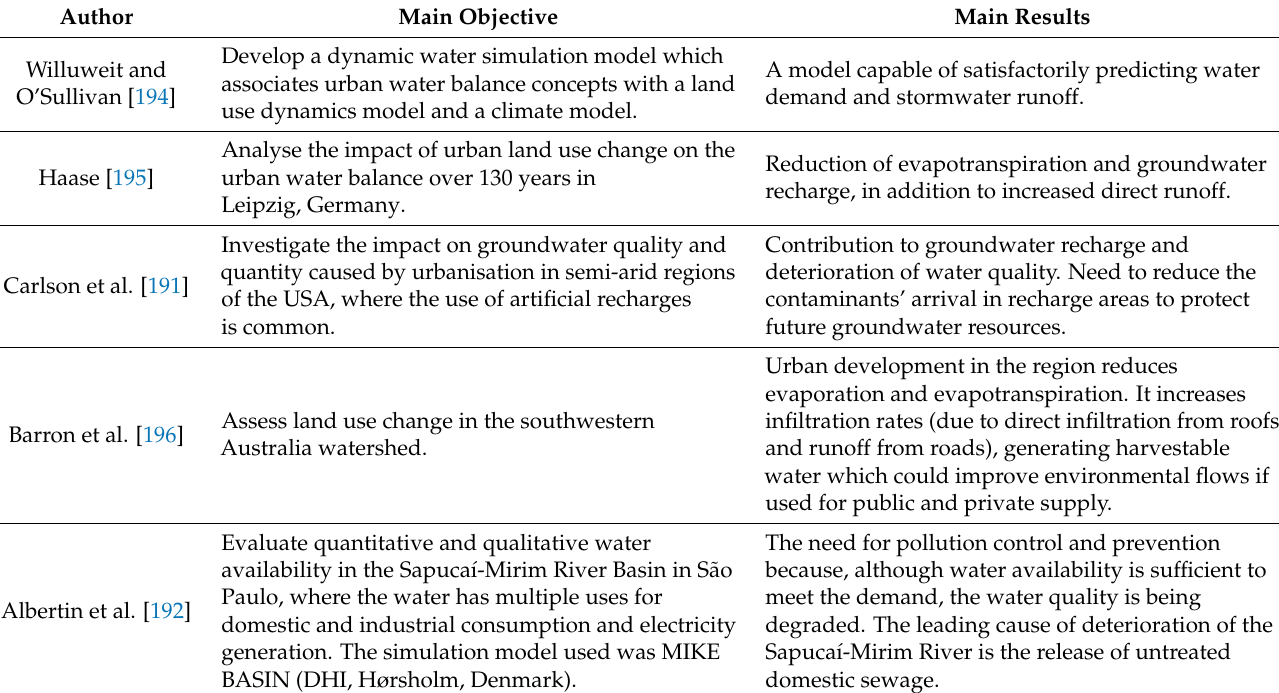
Table 7. Research studies about water balance